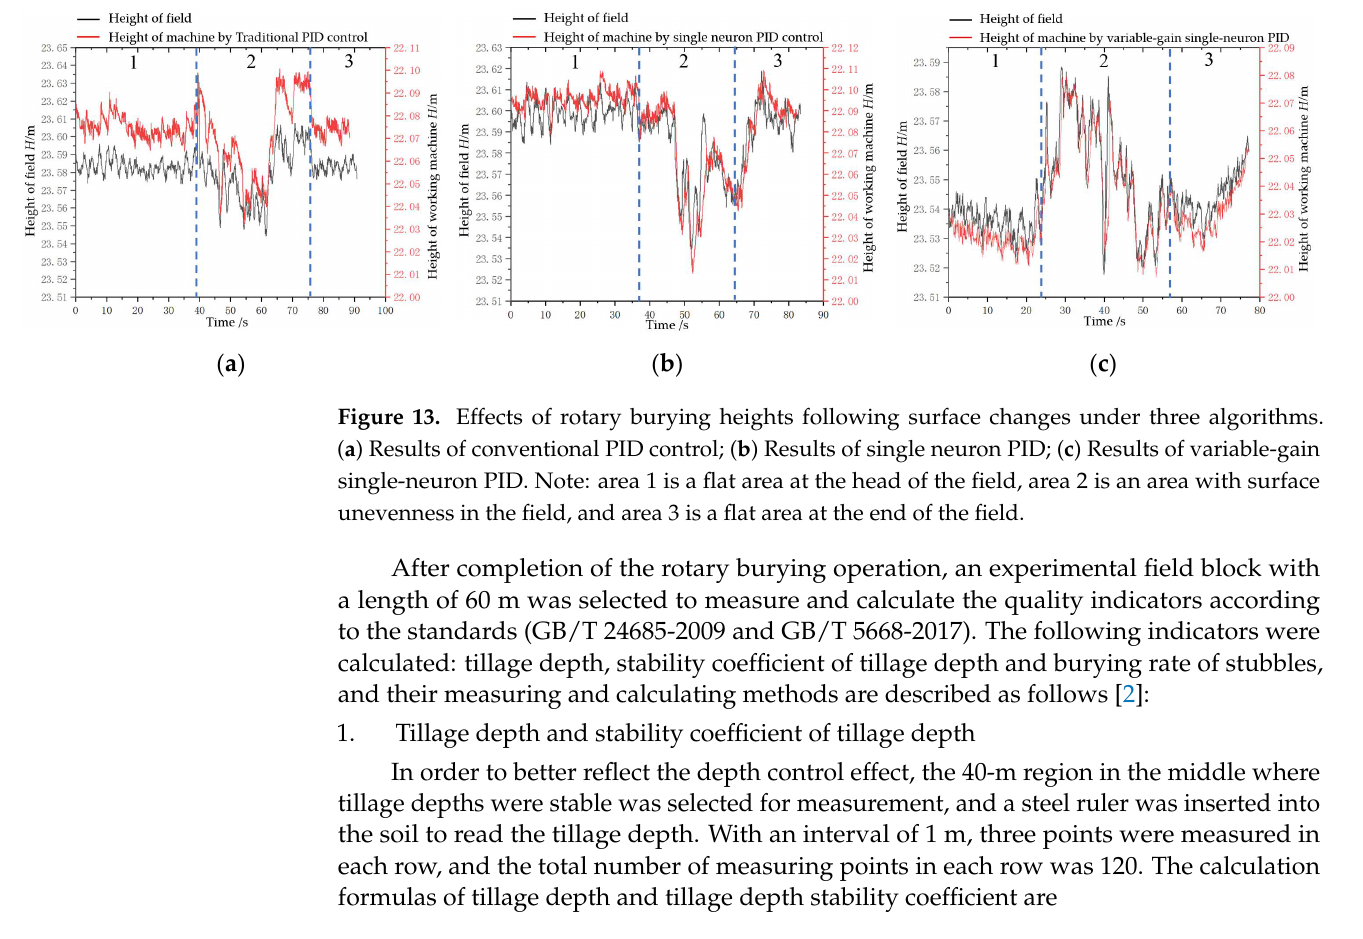
Figure 13. Effects of rotary burying heights following surface changes under three algorithms. ( a ) Results of conventional PID control; ( b ) Results of single neuron PID; ( c ) Results of variable-gain single-neuron PID. Note: area 1 is a flat area at the head of the field, area 2 is an area with surface unevenness in the field, and area 3 is a flat area at the end of the field. After completion of the rotary burying operation, an experimental field block with a length of 60 m was selected to measure and calculate the quality indicators according to the standards (GB/T 24685-2009 and GB/T 5668-2017). The following indicators were cal- culated: tillage depth, stability coefficient of tillage depth and burying rate of stubbles, and their measuring and calculating methods are described as follows [2]: